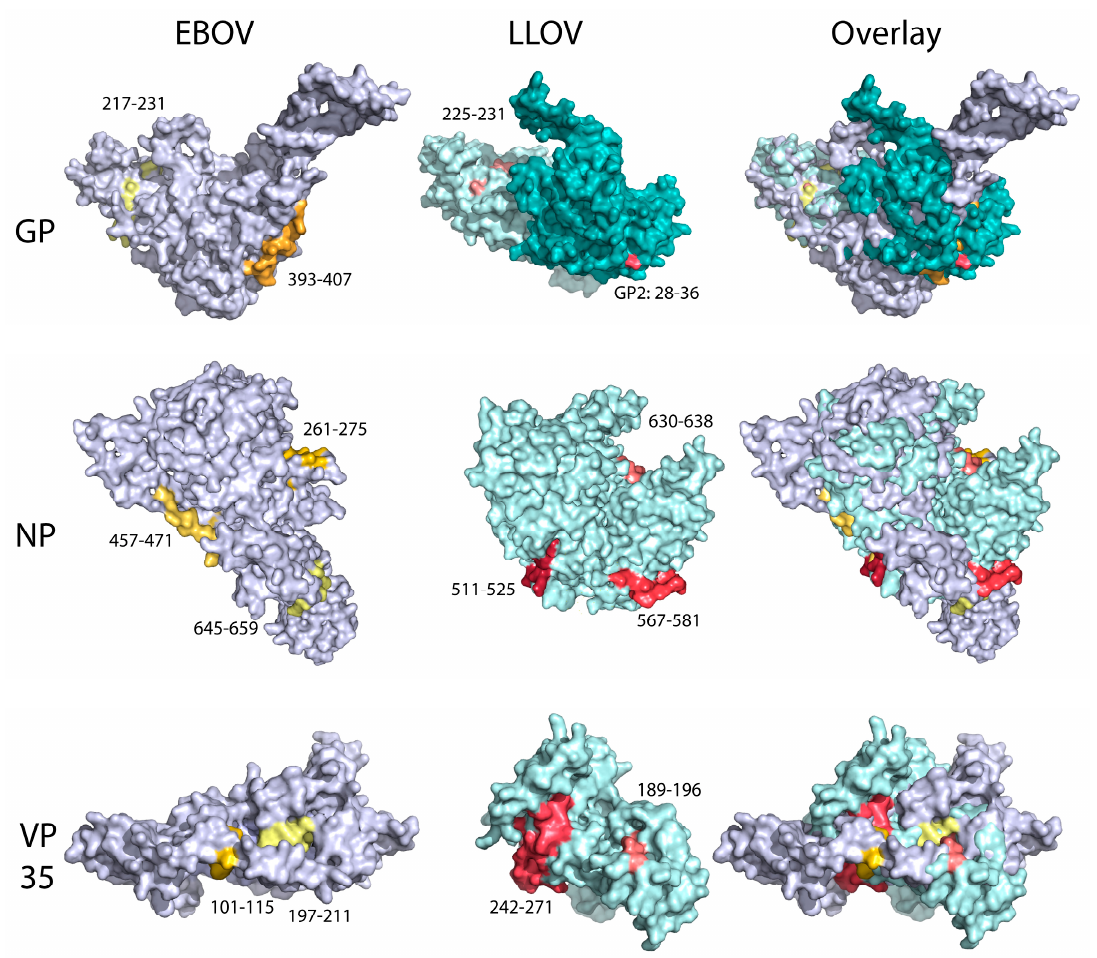
Figure 3. Structural modelling of Ebola (EBOV) (left), Lloviu (LLOV) (middle) and EBOV / LLOV overlay proteins (right). EBOV epitopes are in yellow, gold, and orange (GP: 217–231,393–407; NP: 261–275, 457–471, 473–487; VP35:197–211, 266–280) while LLOV epitopes described are in pink, salmon, and red (GP: 225–231, GP2 28–36, NP: 511–525, 567–581, 630–638, VP35: 189–196, 242–271). LLOV epitopes detected by Schreiber’s Bent-winged bats are in similar regions to the ones described in humans, even when the amino acid sequence of the proteins are dissimilar.